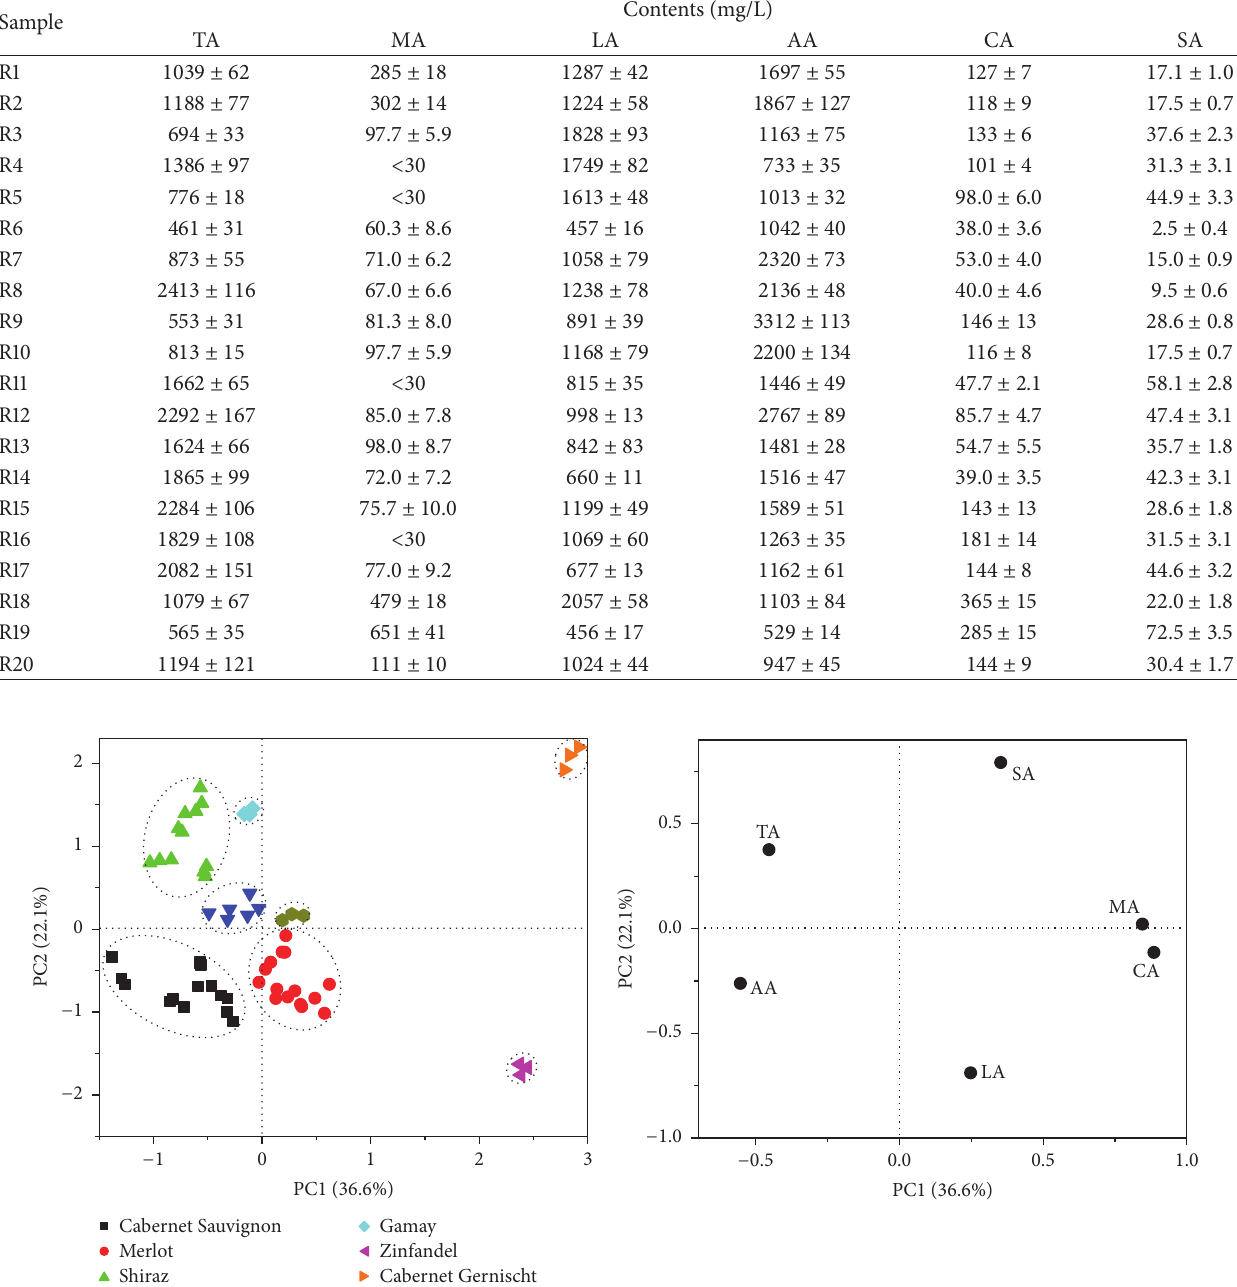
Table 3: Organic acid profiles (mean ± s ; 𝑛 = 3 ) of the wines. See the detailed information of the wines in Table 1. Sample